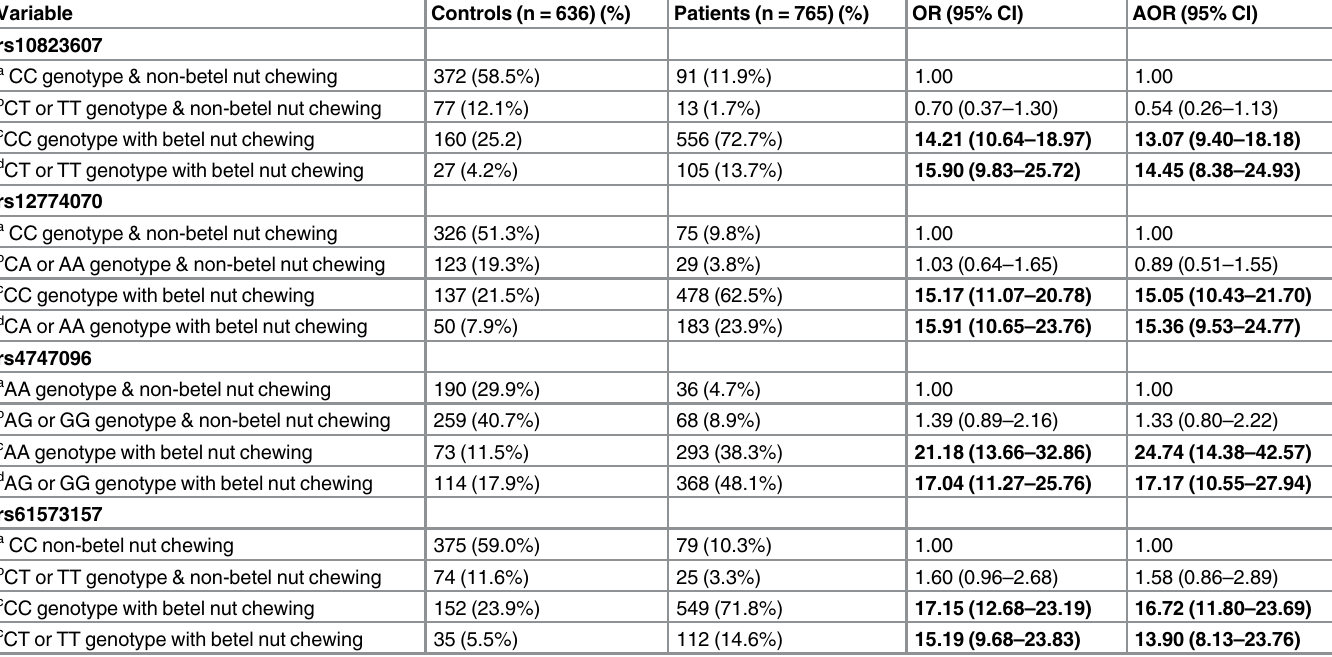
Table 4. Associations of combined effects of ADAMTS14 genotypic frequencies and betel nut chewing with oral cancer among 1401 smokers.